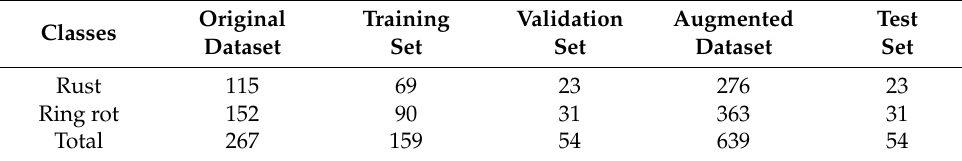
Table 1. The data